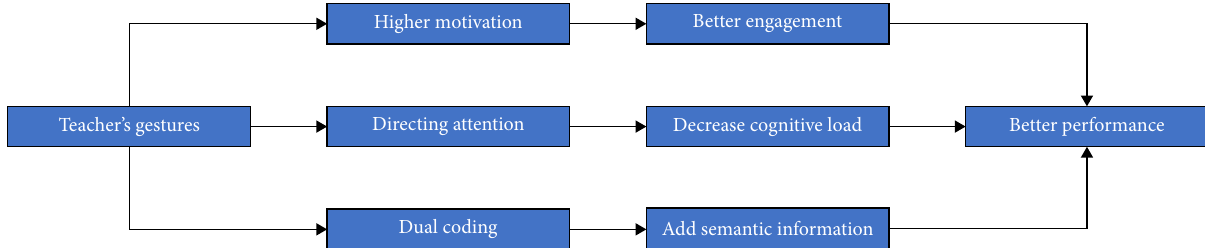
F IGURE 11: A model of how teacher gestures work in instructional